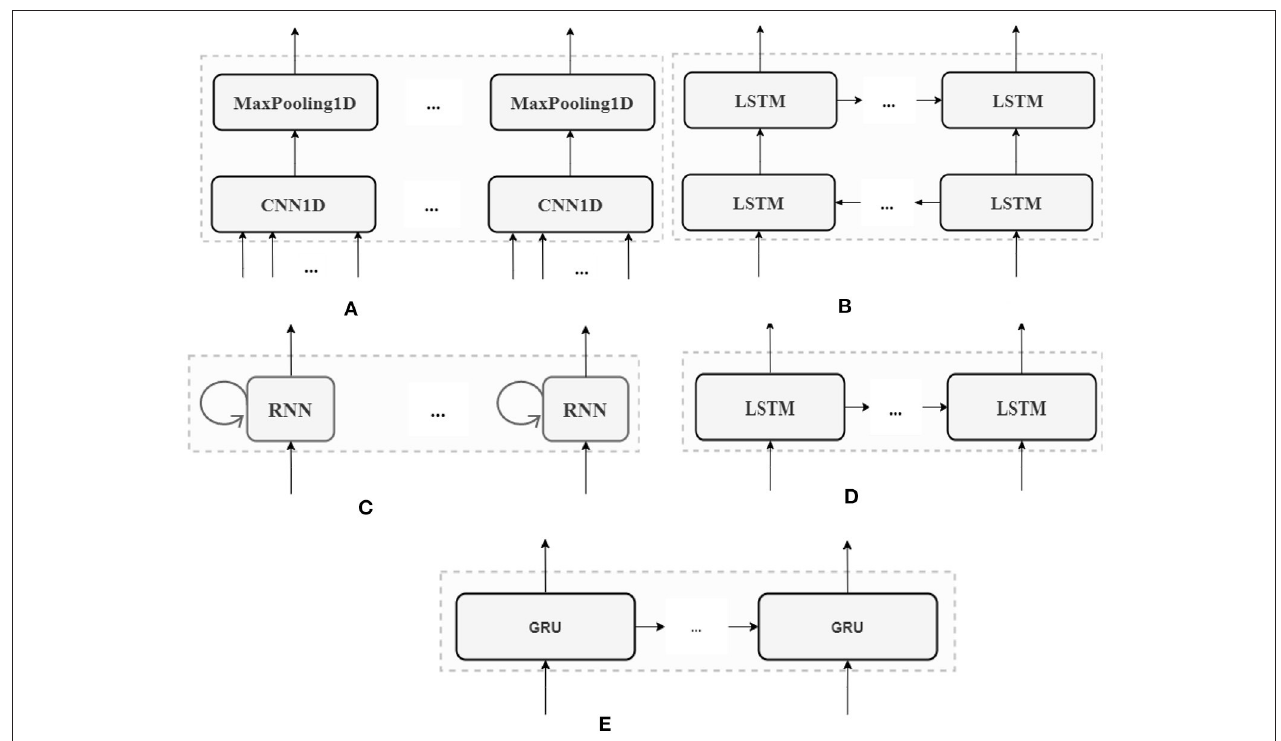
FIGURE 5 | Five DL architectures. (A) CNN1D layer (B) BiRNN layer (C) RNN layer (D) LSTM layer (E) GRU layer.